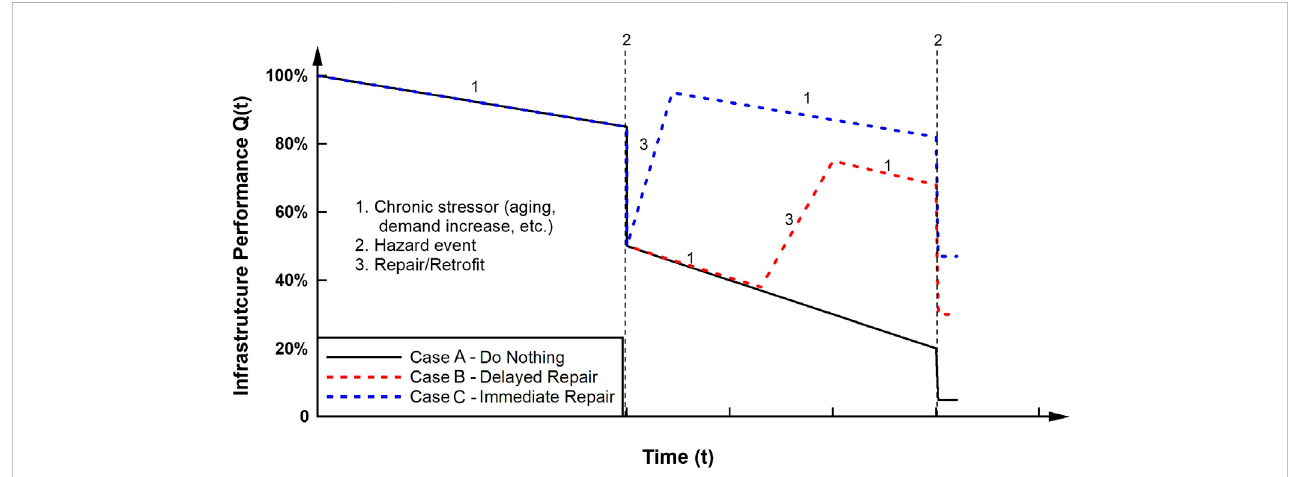
FIGURE 1 Schematic showing change in system performance in subsequent hazards based on repair